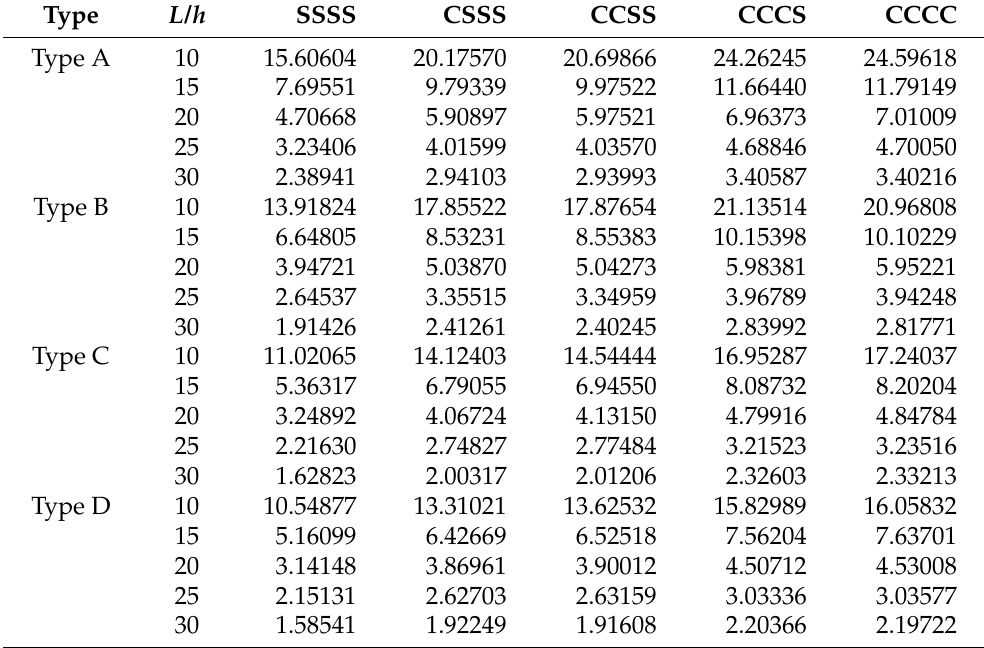
Table 6. Nondimensional frequency Ω of a nanocomposite piezoelectromagnetic plate for different boundary